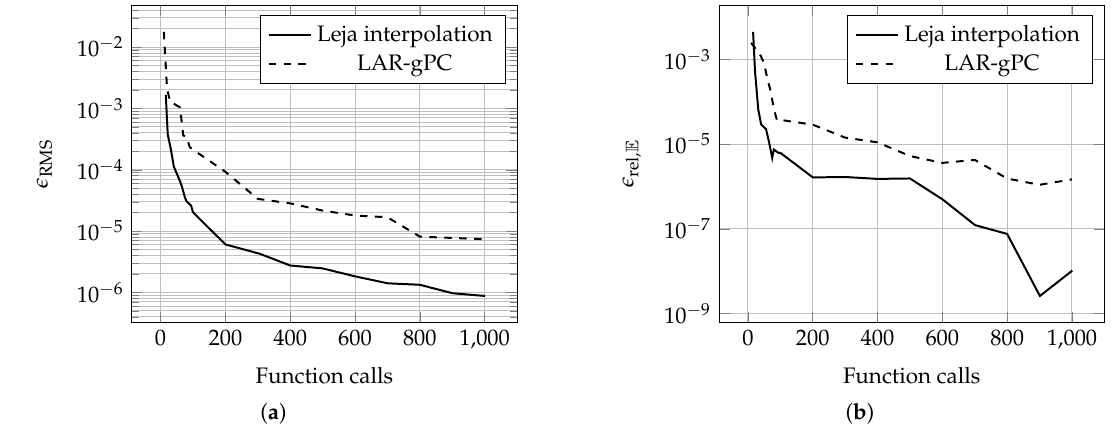
Figure 6. Cost-error relation for the approximations of the dielectric inset waveguide model. The approximations are constructed with a dimension-adaptive weighted Leja interpolation algorithm [37] and with a degree-adaptive LAR-gPC algorithm [9,50]. The size of the validation sample is Q = 10 5 . The reference expected value is computed with quasi-MC integration based on a Sobol sample size equal to 10 8 : ( a ) RMS validation error, ( b ) Expected value relative